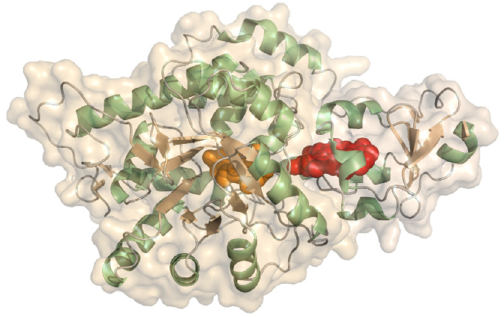
Figure 11. Crystal structure of Saccharomyces cerevisiae L -lactate dehydrogenase (PDB: 1KBI) with the FMN (orange spheres) and the heme b (red spheres) cofactors in close electron transfer-favorable vicinity to each other.